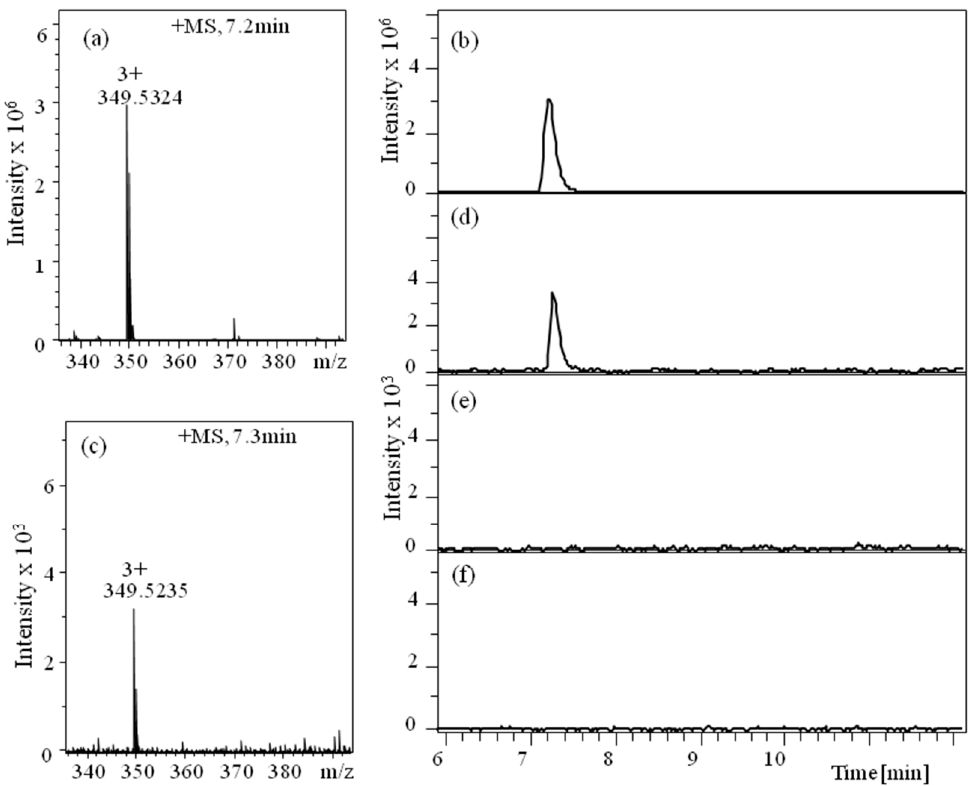
Figure 21. LC-MS identification of translocated Ang II peptide molecules. ( a ) MS reference indicates an m/z ratio of 349.5 (z = 3+) for a lysenin sample. ( b ) LC chromatogram of the reference Ang II. MS ( c ) and LC ( d ) detect and identify Ang II translocated into the negatively charged reservoir. No Ang